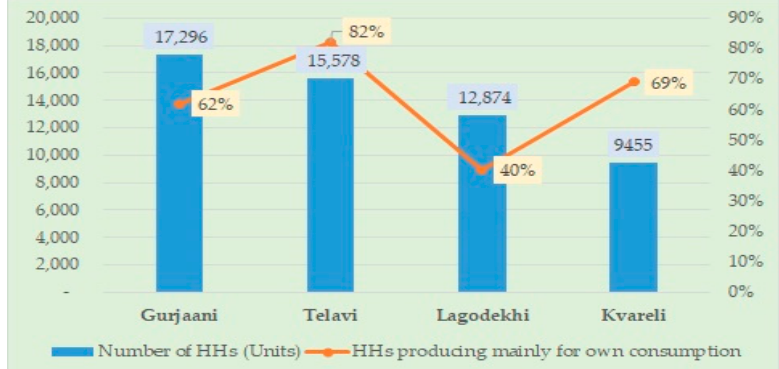
Figure 7. Percentage share of HHs producing for its own consumption.